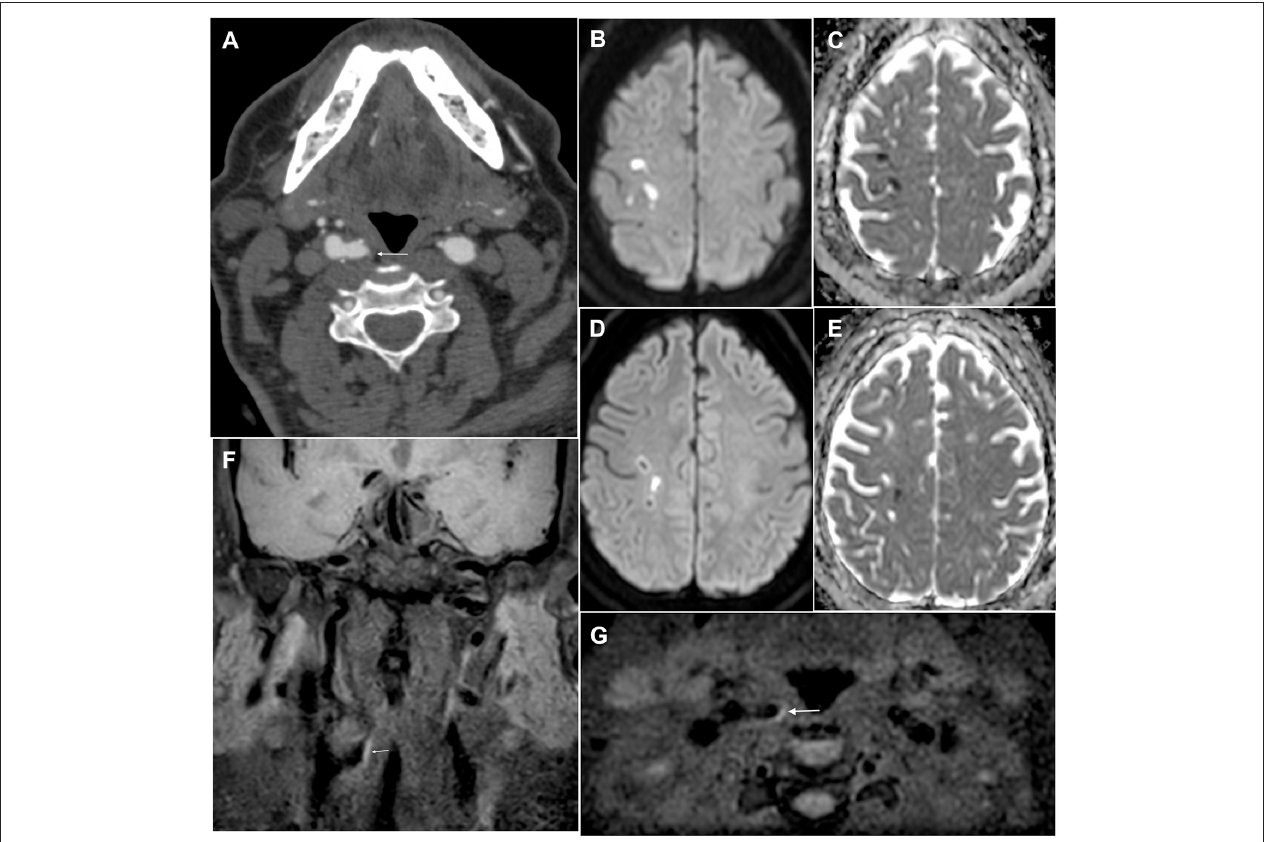
FIGURE 1 | Brain and plaque imaging findings in a 64-year-old man with ESUS. (A) Axial angio-CT scan slice showing a hypodense non-stenotic carotid plaque in the right internal carotid artery (white arrow). (B–E) Axial diffusion-weighted imaging slices (with corresponding ADC maps) showing multiple embolic strokes in the right pre-and post-central area. (F,G) Coronal and axial T1-weighted black blood sequence showing hyperintensity of the non-stenotic plaque in the right internal carotid artery (white arrow), thus confirming the presence of intraplaque